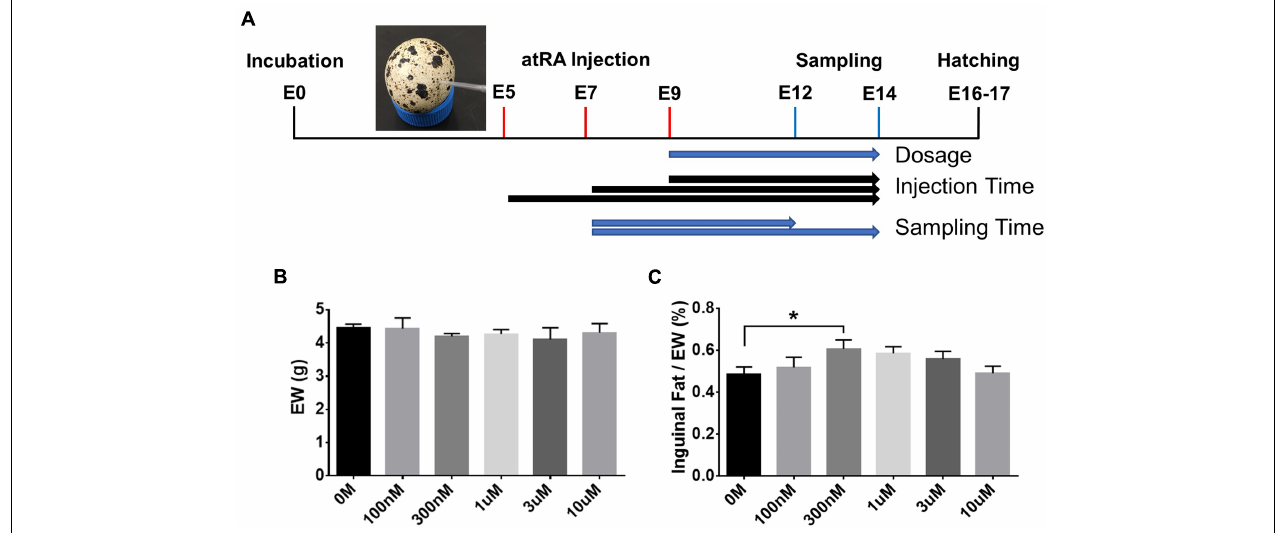
FIGURE 2 | In ovo all- trans retinoic acid injection. (A) Schematic diagram of in ovo all- trans retinoic acid (atRA) injection. Quail eggs were injected with atRA at embryonic day (E) 5, E7, or E9 and sampled at E12 or E14. Embryo weight (EW, B ) and percentages of inguinal fat weight in total EW (C) . Dose of 0 M, 100 nM, 300 nM, 1 µ M, 3 µ M, or 10 µ M of atRA was injected in ovo at E9, and injected embryos were sampled at E14. n = 11, 7, 12, 12, 5, and 7 embryos for 0 M, 100 nM, 300 nM, 1 µ M, 3 µ M and 10 µ M of atRA, respectively. All data were expressed as means ± SEM. The data were analyzed by multiple t -test using GraphPad Prism software, version 6.02. * p <